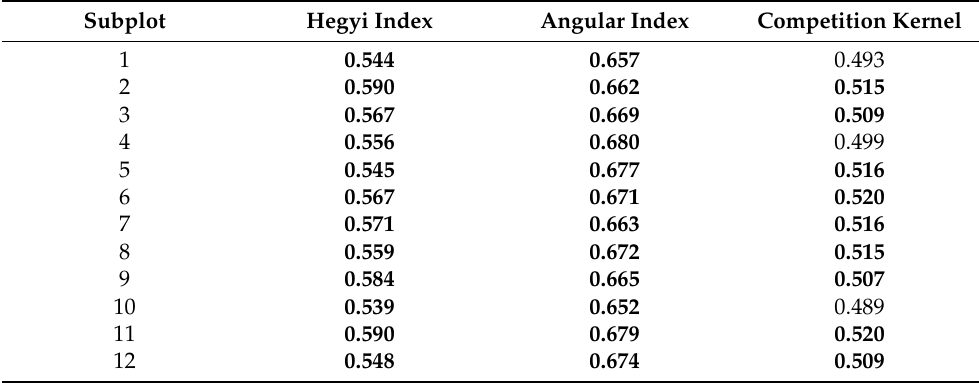
Table 3. The values of Spearman correlation coefficients between the 5-year tree diameter increment and three different competition indices for 12 sample subplots of the Heinävesi experimental site. The values > 0.5 in absolute magnitude are shown in